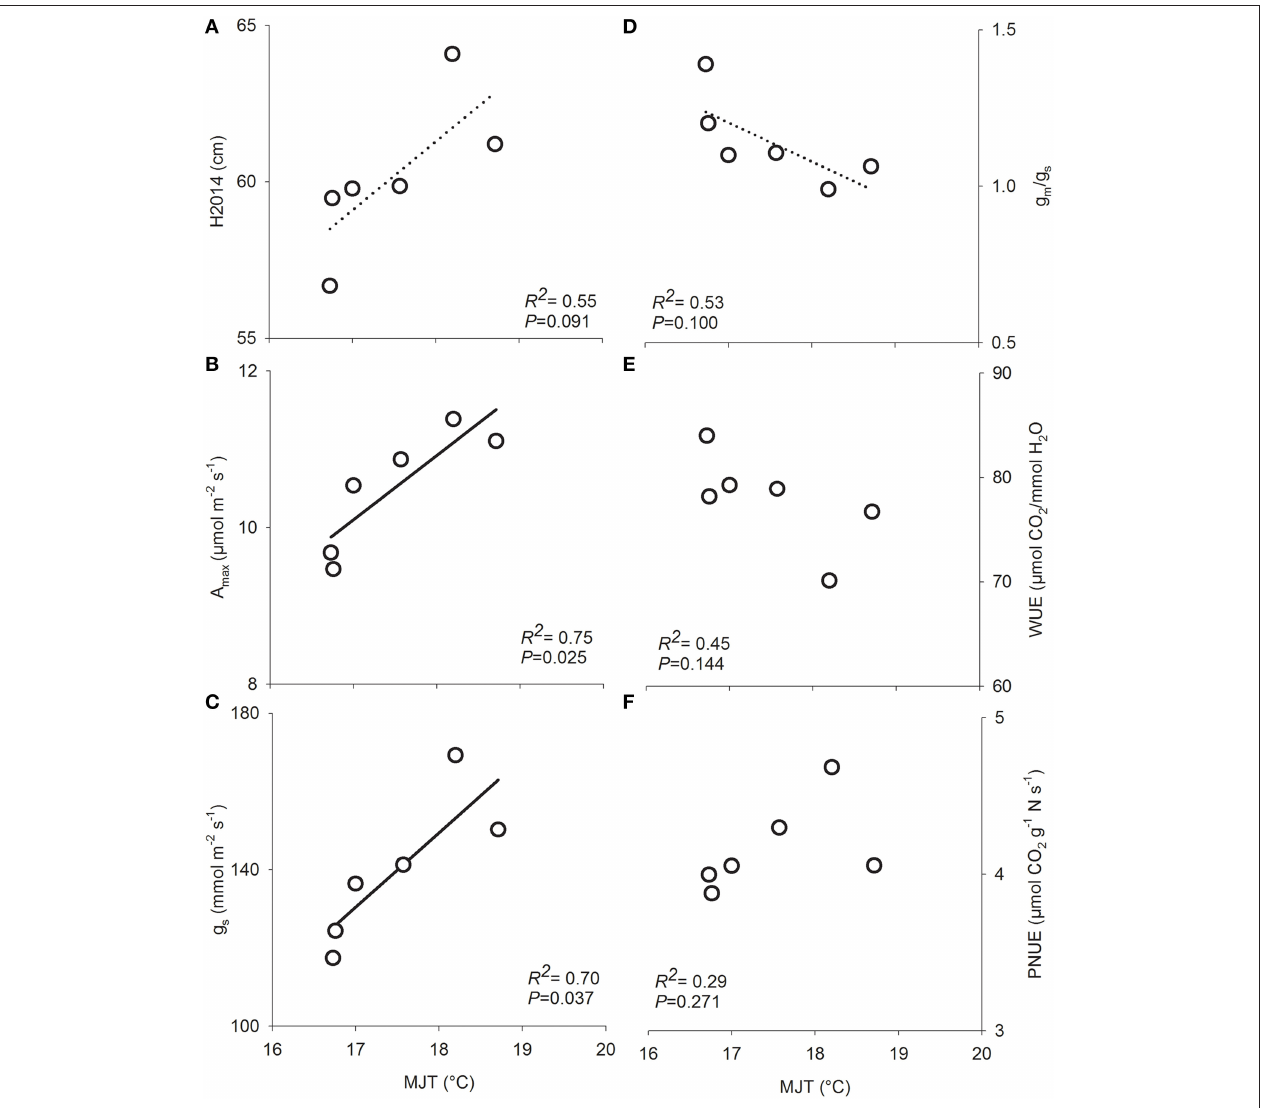
FIGURE 4 | Relationships between functional traits in six white spruce seed sources and the mean July temperature at their origin (MJT) after growing on three forest sites. (A) Total height at the end of the second growing season (H2014), (B) light-saturated photosynthesis on a projected leaf area basis ( A max ), (C) stomatal conductance ( g s ), (D) mesophyll to stomatal conductance ratio ( g m / g s ), (E) water use efficiency (WUE), and (F) photosynthetic nitrogen-use efficiency (PNUE). Data points are means of 12 seedlings for functional traits and 768 seedlings for growth (H2014). Regression lines and coefficient of determination ( R 2 ) values are shown for significant relationships, with solid line for P < 0.05 and dashed lines for P < 0.1 ( n = 6